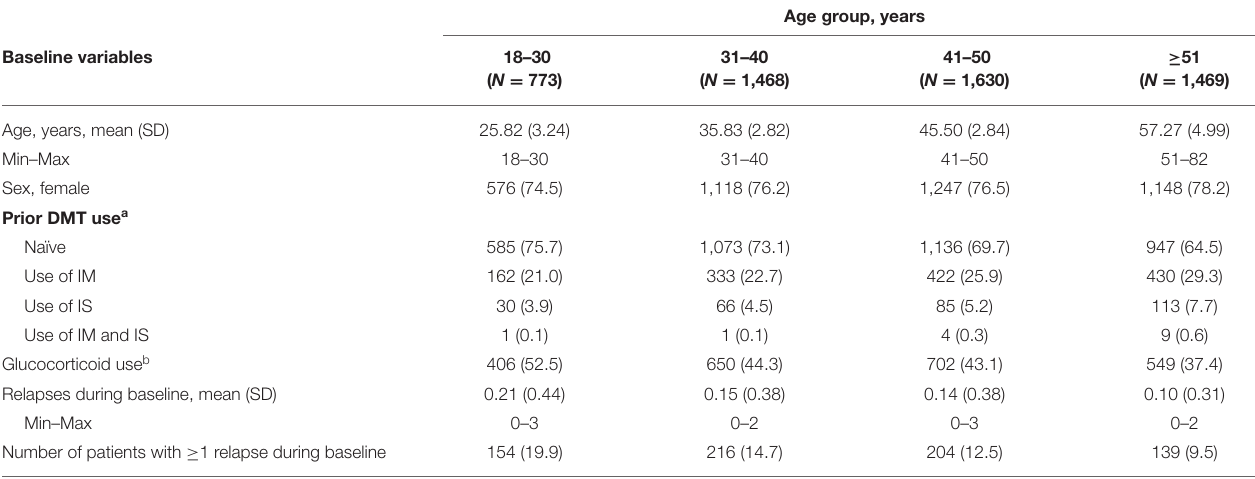
TABLE 1 | Patient demographic and clinical characteristics at index.